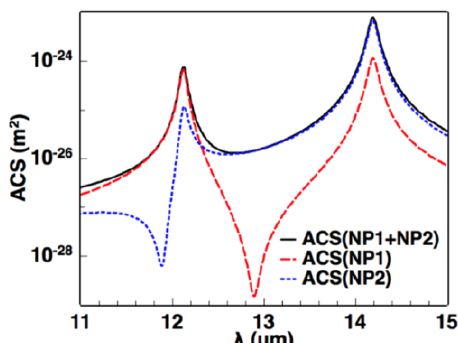
Figure 7. Absorption cross-section spectrum of total (black solid), NP1 (red dashed), and NP2 (blue dotted) contributions from the graphene-wrapped dimer,